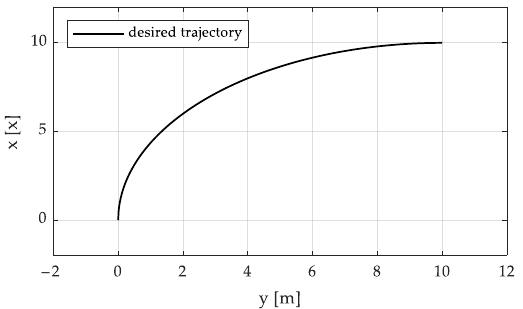
Figure 8. The desired trajectory of the barge ship that was used in the simulations.